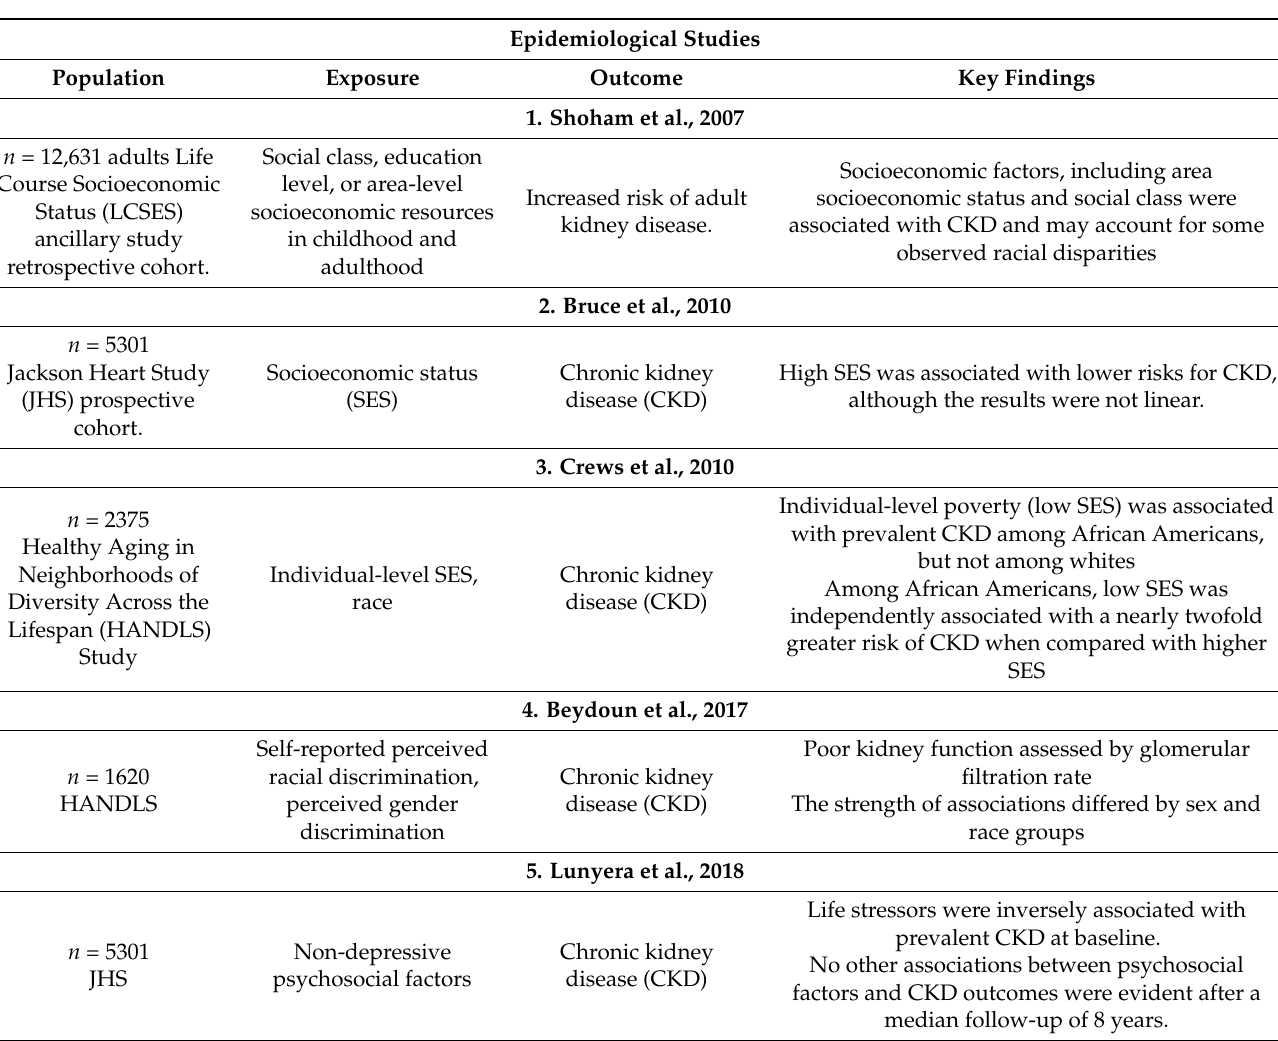
Table 2. Findings from the included articles reporting the association between psychosocial stressors and kidney outcomes in experimental and epidemiological